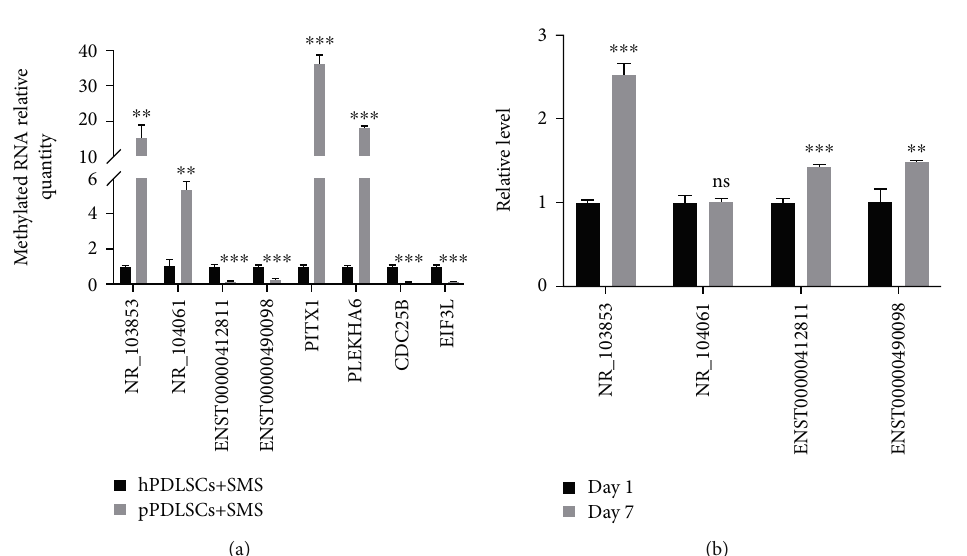
Figure 3: Con fi rmation of di ff erentially methylated lncRNAs. Two hypermethylated lncRNAs, two hypomethylated lncRNAs, two hypermethylated mRNAs, and two hypomethylated mRNAs were con fi rmed by RIP-qPCR (a). The relative level of di ff erentially methylated lncRNAs before and after osteogenic induction (b). ∗ p < 0 : 05 , ∗∗ p < 0 : 01 , ∗∗∗ p < 0 : 001